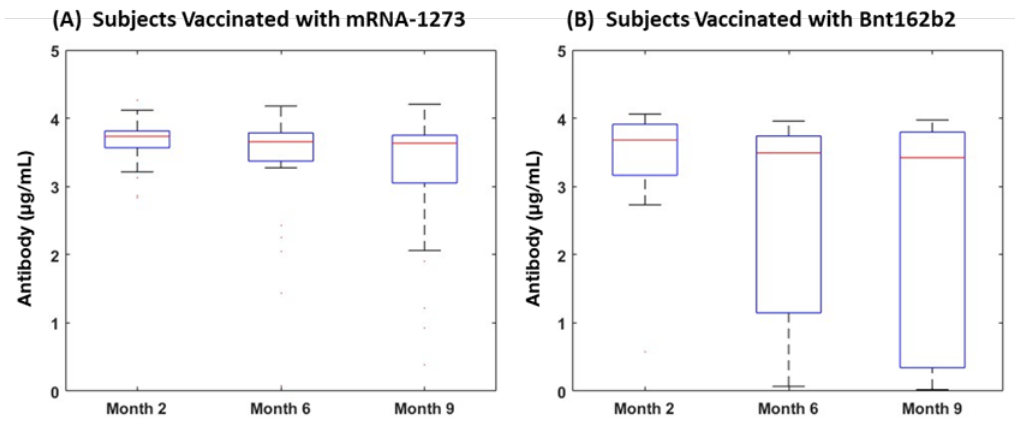
Figure 4. Changes in Antibody over Time per Vaccine Use for Subjects with COVID-19 Infection History. ( A ) Antibody responses ( µ g/mL) in individuals vaccinated with mRNA-1273 at Month 2 (n = 29), Month 6 (n = 29), and Month 9 (n = 25); ( B ) antibody responses ( µ g/mL) in those vaccinated with Bnt162b2 at Month2 (n = 16), Month 6 (n = 15), and Month 9 (n = 9) in subjects with a history of prior COVID-19 infection history at baseline. Levels of antibodies in both cohorts did not show statistical declines over time.